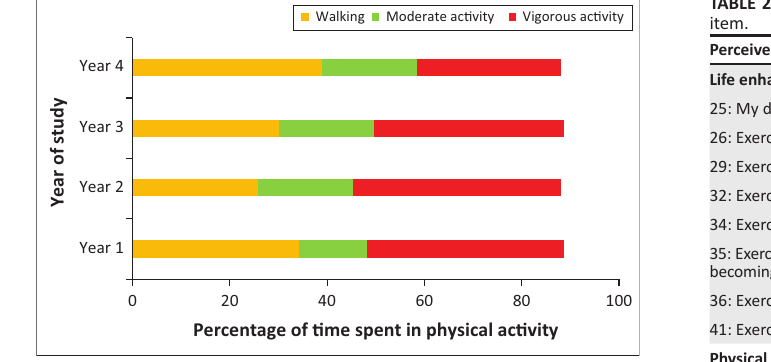
FIGURE 3: Percentage of time spent walking, doing moderate or vigorous physical activity by year ( n =